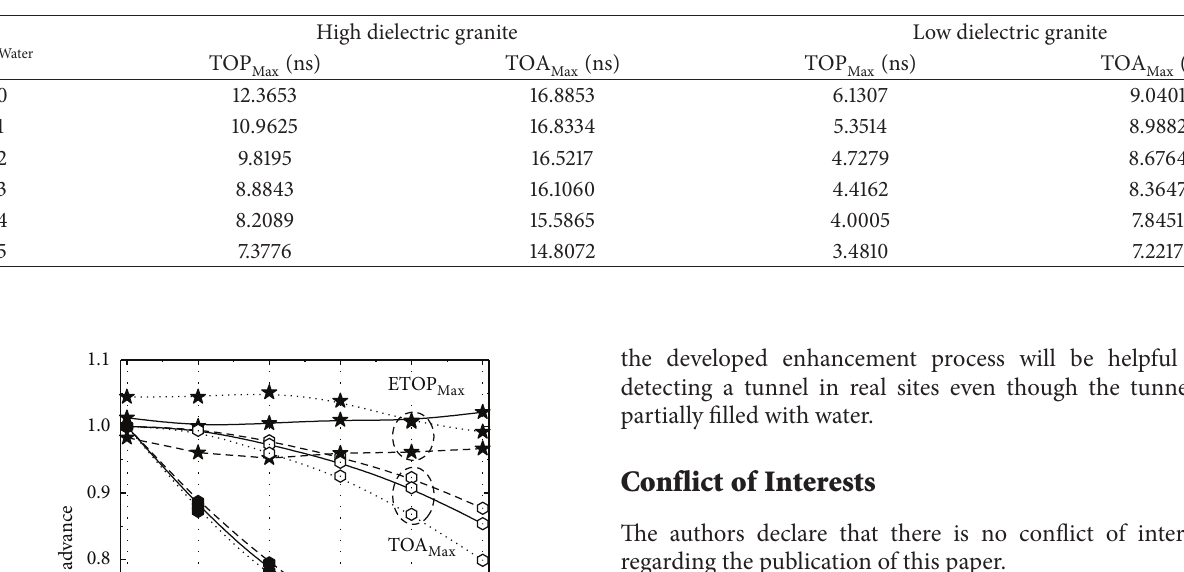
Table 2: The fastest TOP (TOP Max ) and the fastest TOA (TOA Max ) for 6 different height ratios of water in a tunnel ( 𝐻 the low and high dielectric properties of granite.